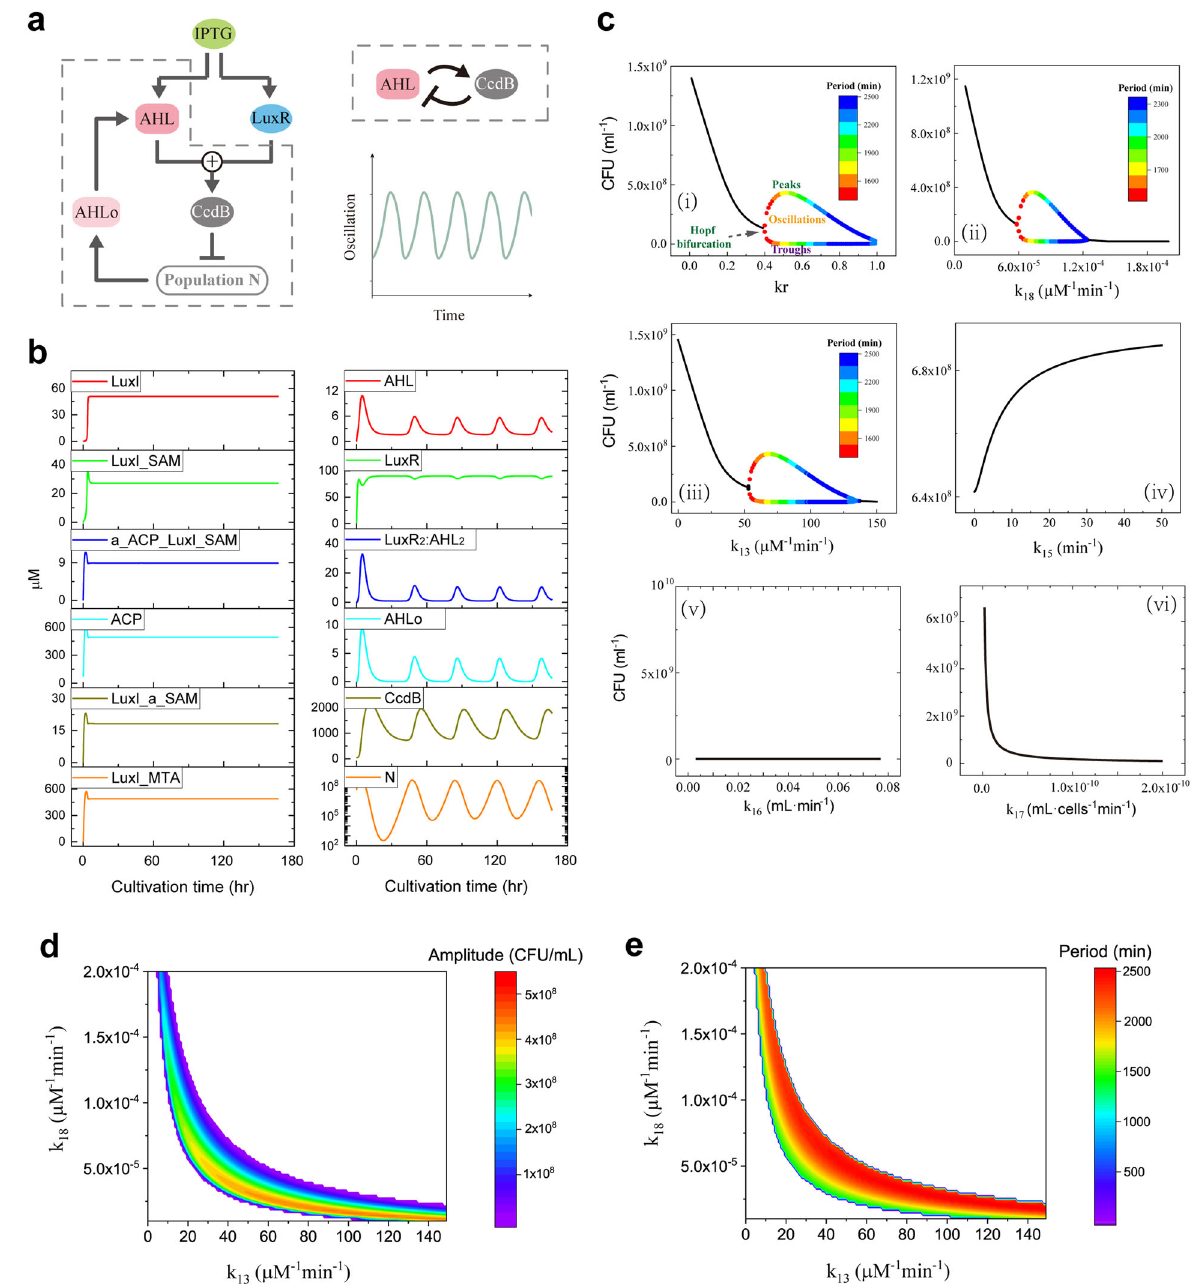
Fig. 6 Mechanism analysis of oscillation in the quorum sensing system. a Schematic diagram of the negative feedback loop structure in the quorum sensing system. b Time courses of the key components in the two major parts shown in Fig. 1. c Bifurcation diagrams of the six represented parameters in modulating bacterial density. d – e Two-parameter bifurcation diagrams of the amplitude and period as a function of k 13 and k 18 . Oscillation occurs within the color region and no oscillation occurs in the white oscillation behavior (Fig. 5d), the toxic metabolic coef fi cient We further examine whether the oscillation is indeed induced (parameter a) is fi xed at 0. Bifurcation diagram of cell density with by the negative feedback loop. Kinetics of the key components in k r , which is a key factor involved in the negative feedback the two parts of the quorum sensing signaling are presented in Fig. 6b. For the bacterial density that exhibits oscillation, structure, is shown in Fig. 6ci. The solid black lines represent the oscillatory behavior occurs in the right part of the AHL-triggered stable equilibrium points of the system. The colored lines cell death in Fig. 1 (Fig. 6b, right panel). While the left part of the represent the maximum and minimum amplitudes of the loop circuit-induced AHL synthesis reaches stability (Fig. 6b, left oscillations and the colors of the dots indicate the periods. Figure panel). Hence, only the part that includes the negative feedback 6ci shows that when k r is small, the steady state of the bacterial loop exhibits oscillatory behavior in the quorum sensing signaling. density is decreased with the increase of k r , but when k r is beyond Bifurcation analysis is employed to explore the emergence of a value about 0.4, the bacterial density presents oscillatory the periodic oscillation. Since the toxic factors largely limit the behaviors. The oscillation amplitude is fi rst increased and then